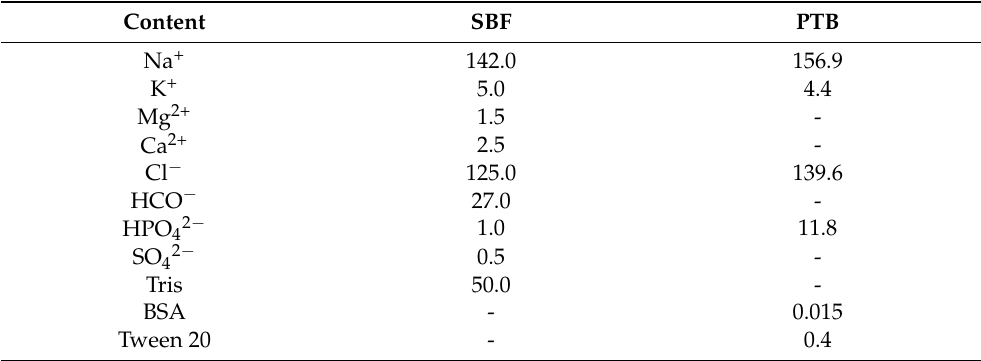
Table 1. Composition (mM) of release media. Simulated body fluid (SBF), Phosphate buffered saline supplemented with tween and bovine serum albumin